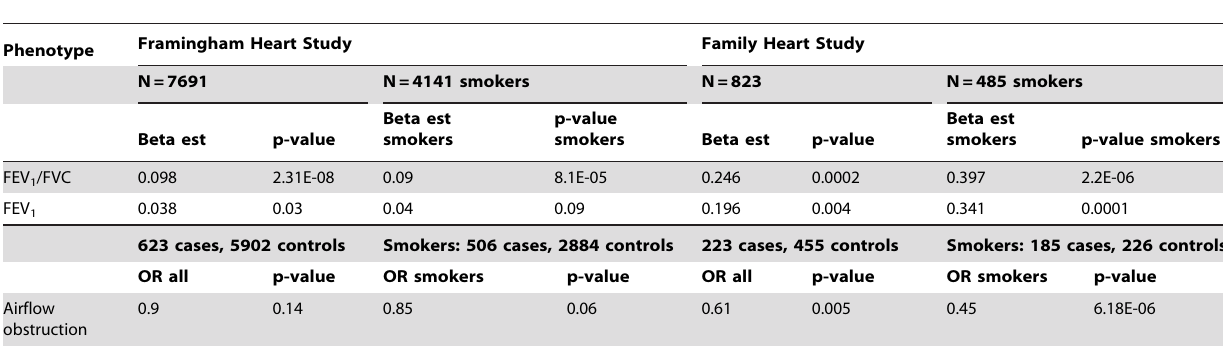
Table 5. Association results for rs13147758 with percent predicted FEV 1 /FVC, FEV 1 , and airflow obstruction across studies and in subset of ever